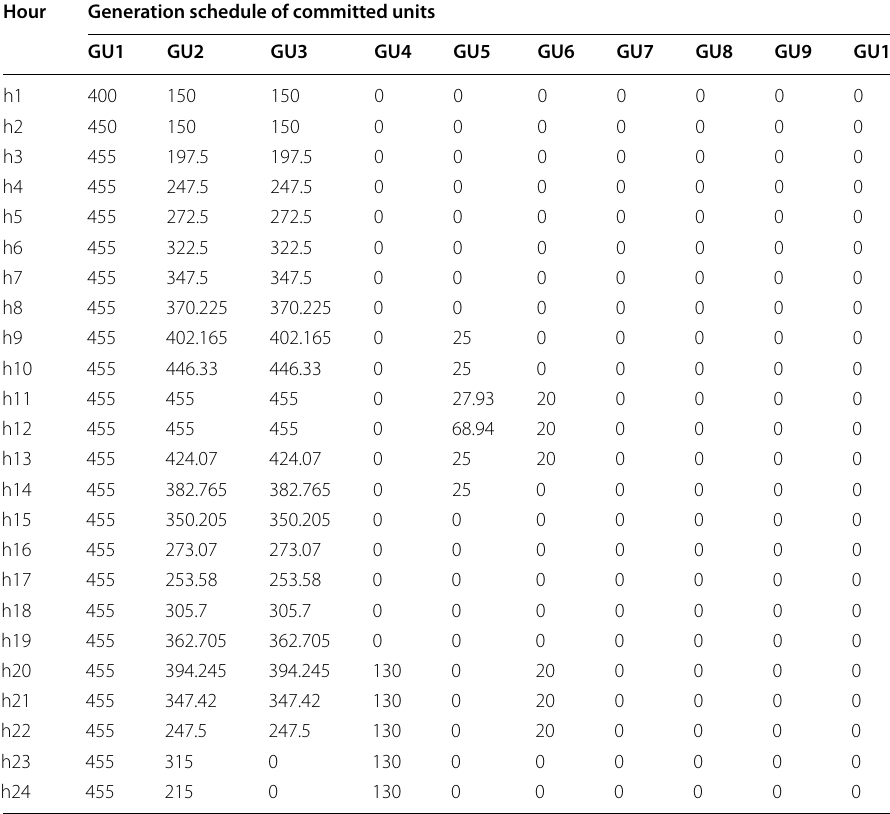
Table 5 Power scheduling for 10-generating unit system (10% SR) considering renewable energy in summer